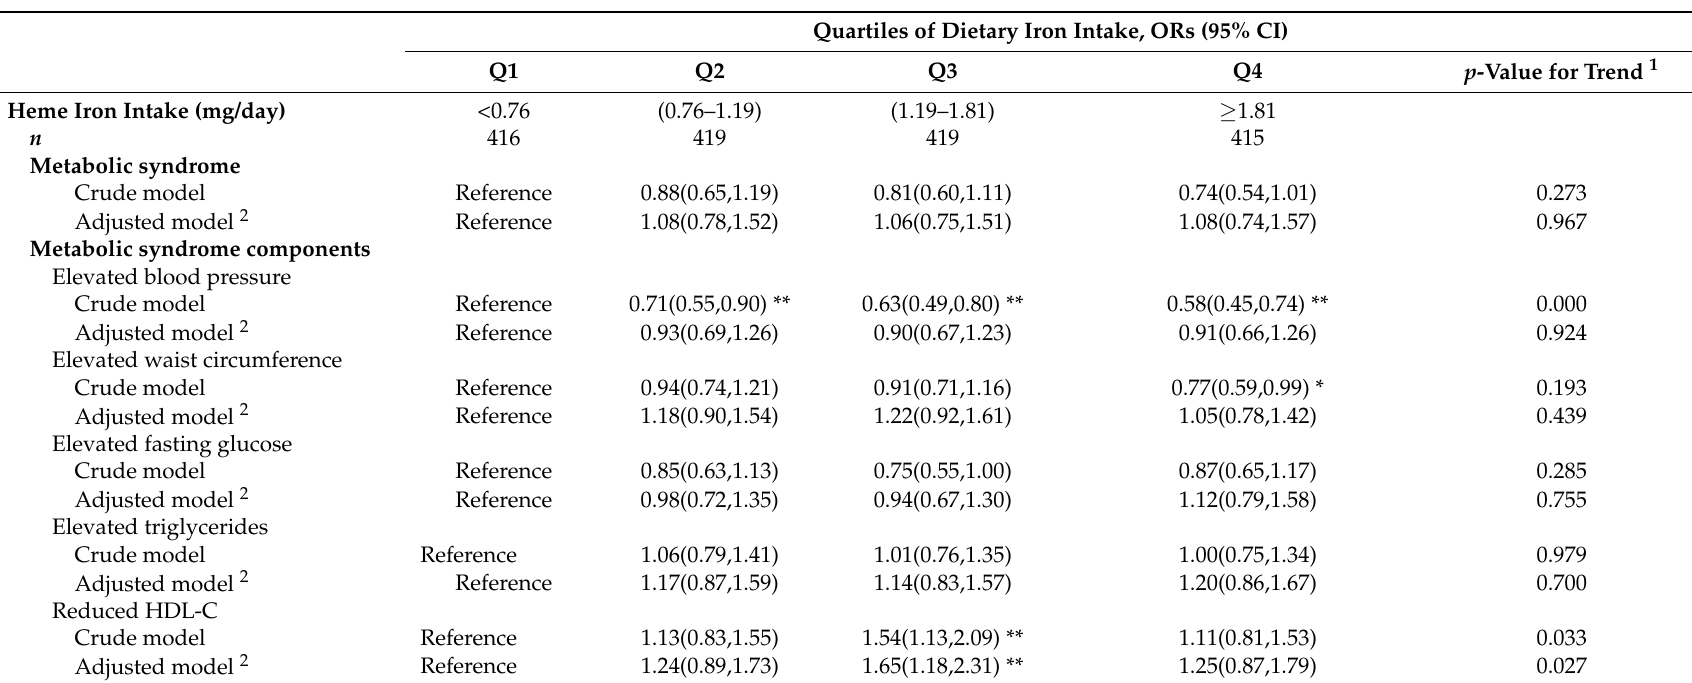
Quartiles of Dietary Iron Intake, ORs (95% CI)